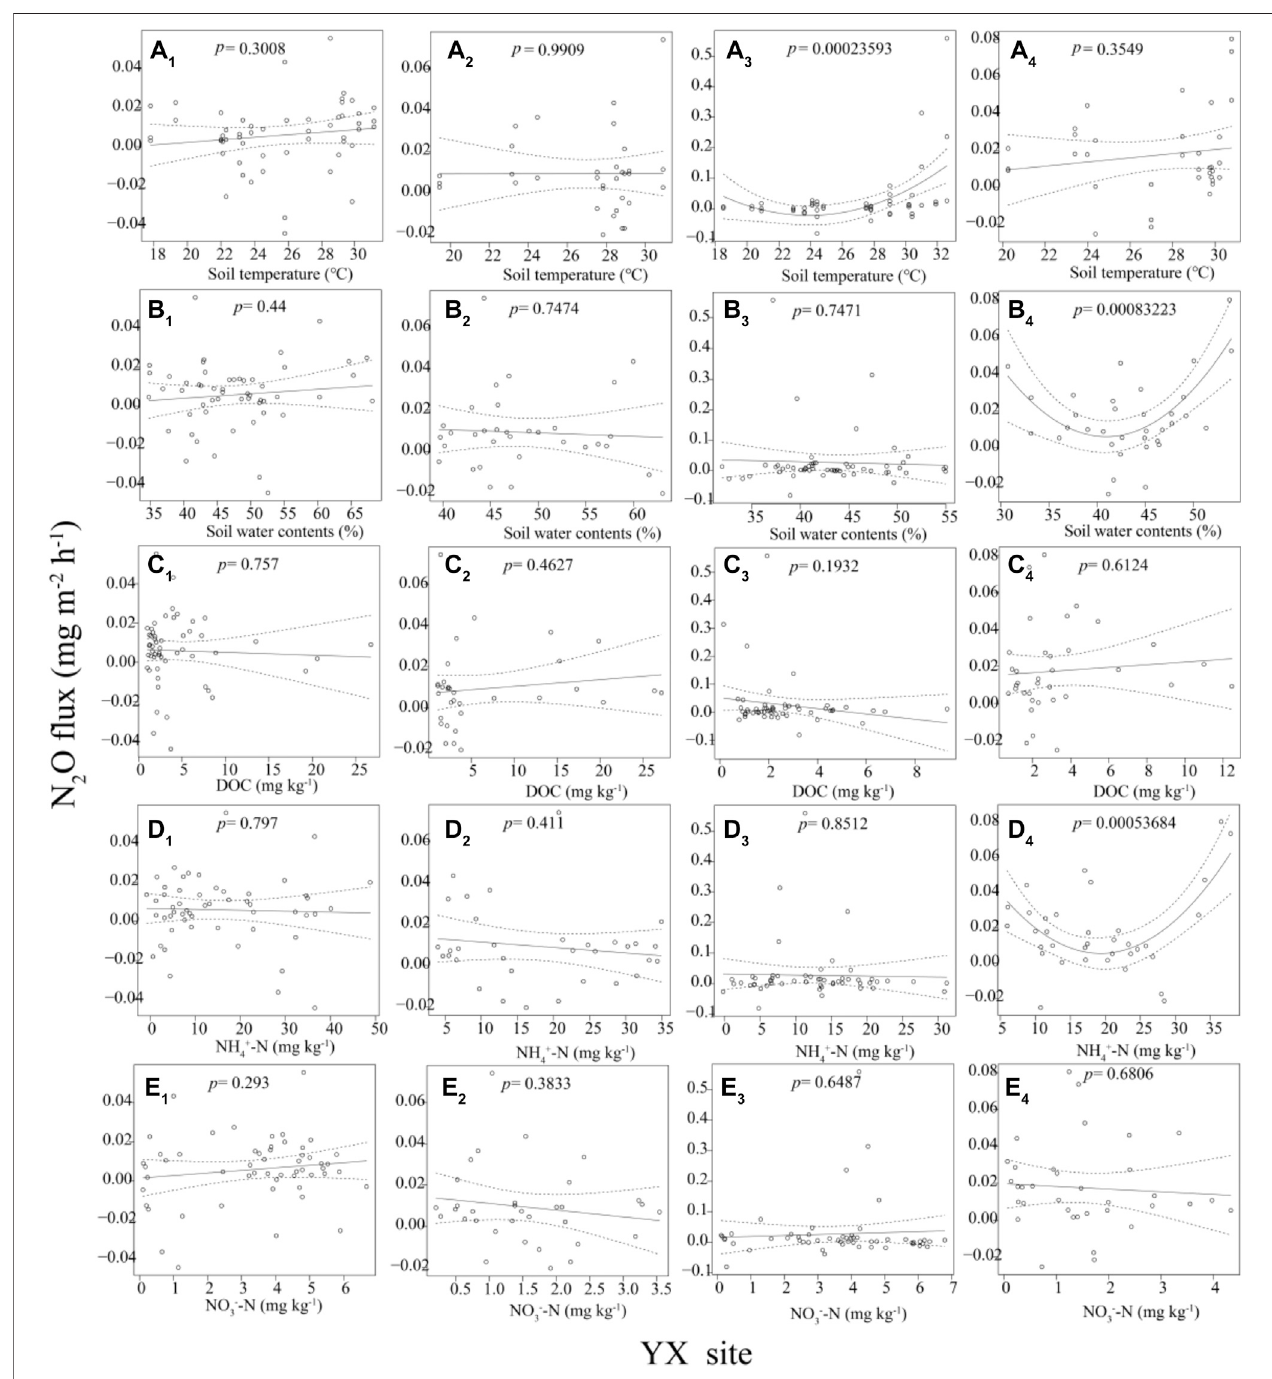
FIGURE 3 | A 1 , B 1 , C 1 , D 1 , and E 1 means the relationships between N 2 O fl uxes and soil temperature, soil water content, DOC contents, NH 4+ -N contents, and NO 3 − -N contentsintheCWR 0 ,respectively.A 2 ,B 2 ,C 2 ,D 2 ,andE 1 meanstherelationshipsbetweenN 2 O fl uxesandsoiltemperature,soilwatercontent,DOCcontents, NH 4+ -N contents, and NO 3 − -N contents in the CWR 1 , respectively. A 3 , B 3 , C 3 , D 3 , and E 3 means the relationships between N 2 O fl uxes and soil temperature, soil water content,DOCcontents,NH 4 + -Ncontents,andNO 3 − -NcontentsintheNWR 0 ,respectively.A 4 ,B 4 ,C 4 ,D 4 ,andE 4 meanstherelationshipsbetweenN 2 O fl uxesand soil temperature, soil water content, DOC contents, NH 4+ -N contents, and NO 3 − -N contents in the NWR 1 , respectively.